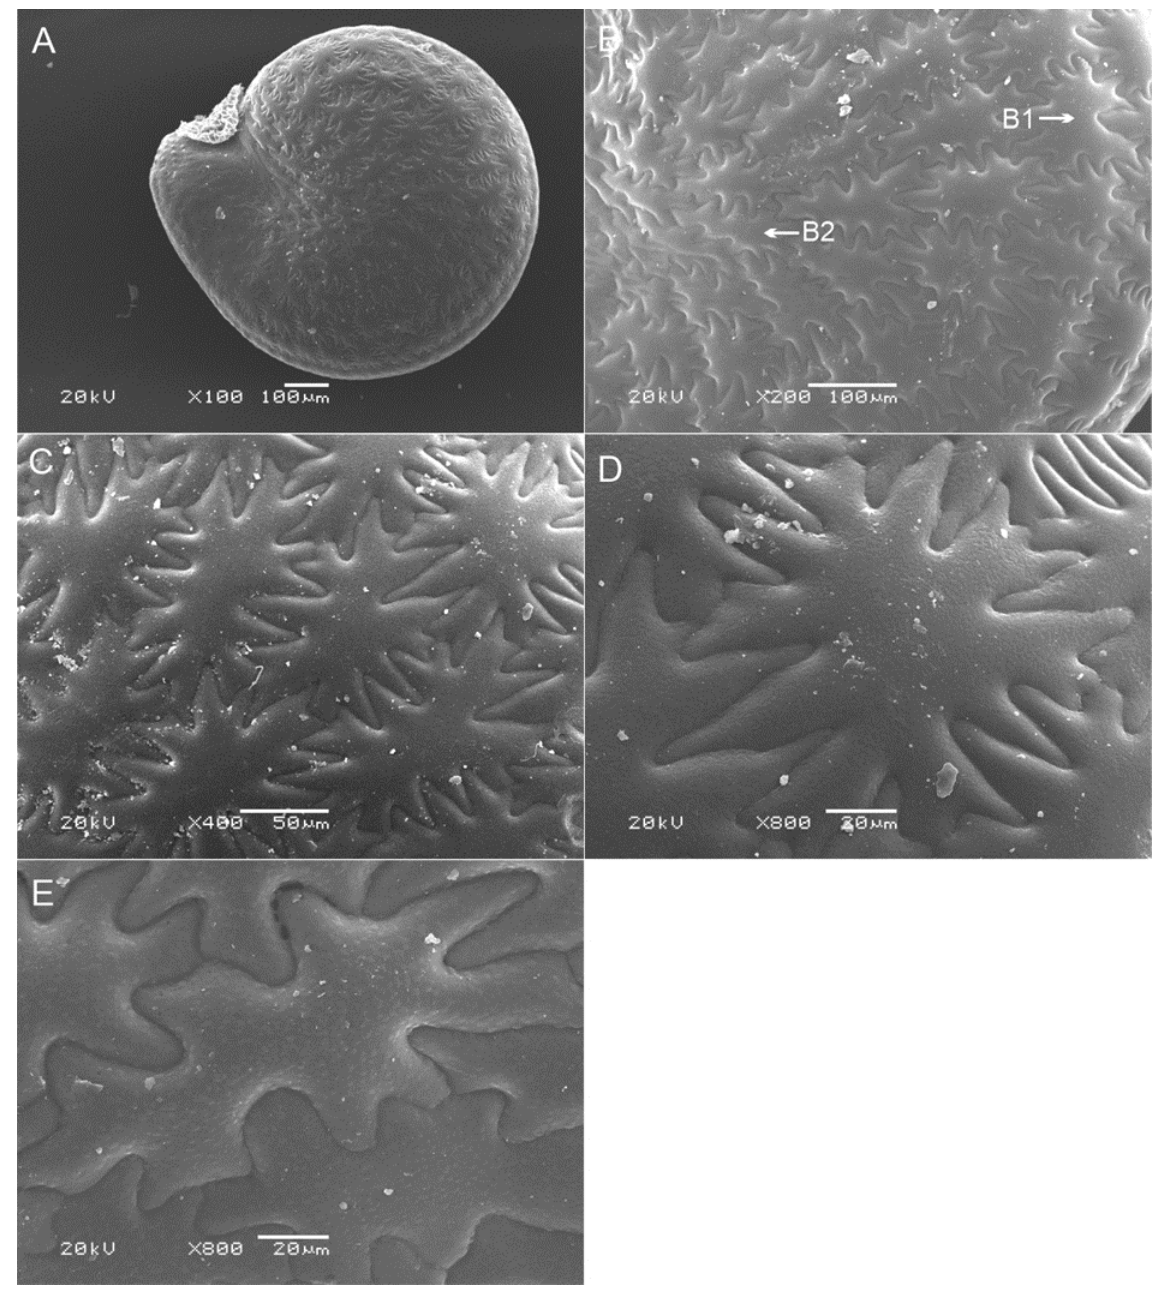
Figure 6 Portulaca oleracea s. str. (SEM). General view of the seed ( A ). e seed surface ( B,C ). Isodiametric cell ( B1 ), elongated cell ( B2 ); general view of the cells ( D,E